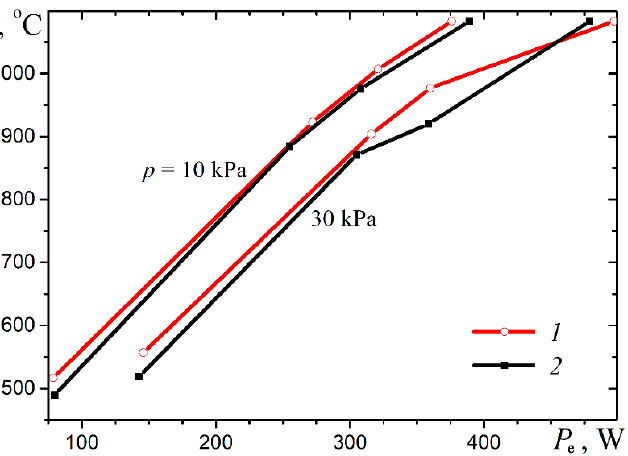
Figure 5. Temperature of the copper sample as a function of electric power in the experiments with different values of argon pressure when the probe laser is (1) turned on or (2) turned off during the experiment.